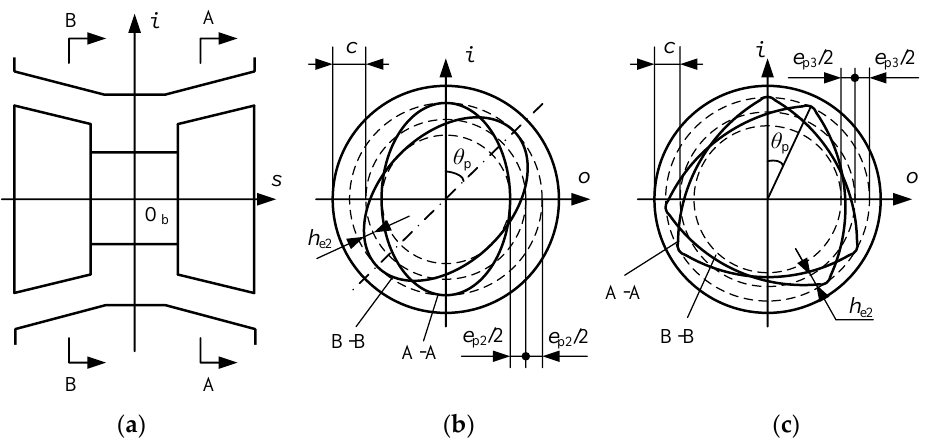
Figure 4. Schematic of oval error and trigone error of bearing: ( a ) front view, ( b ) oval error, ( c ) trigone error.